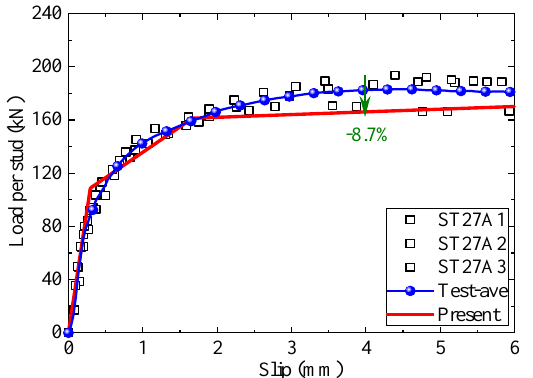
Figure 11. The comparison of load–slip curves between the test, empirical formulae, and the analytical method for ST27A1-3.